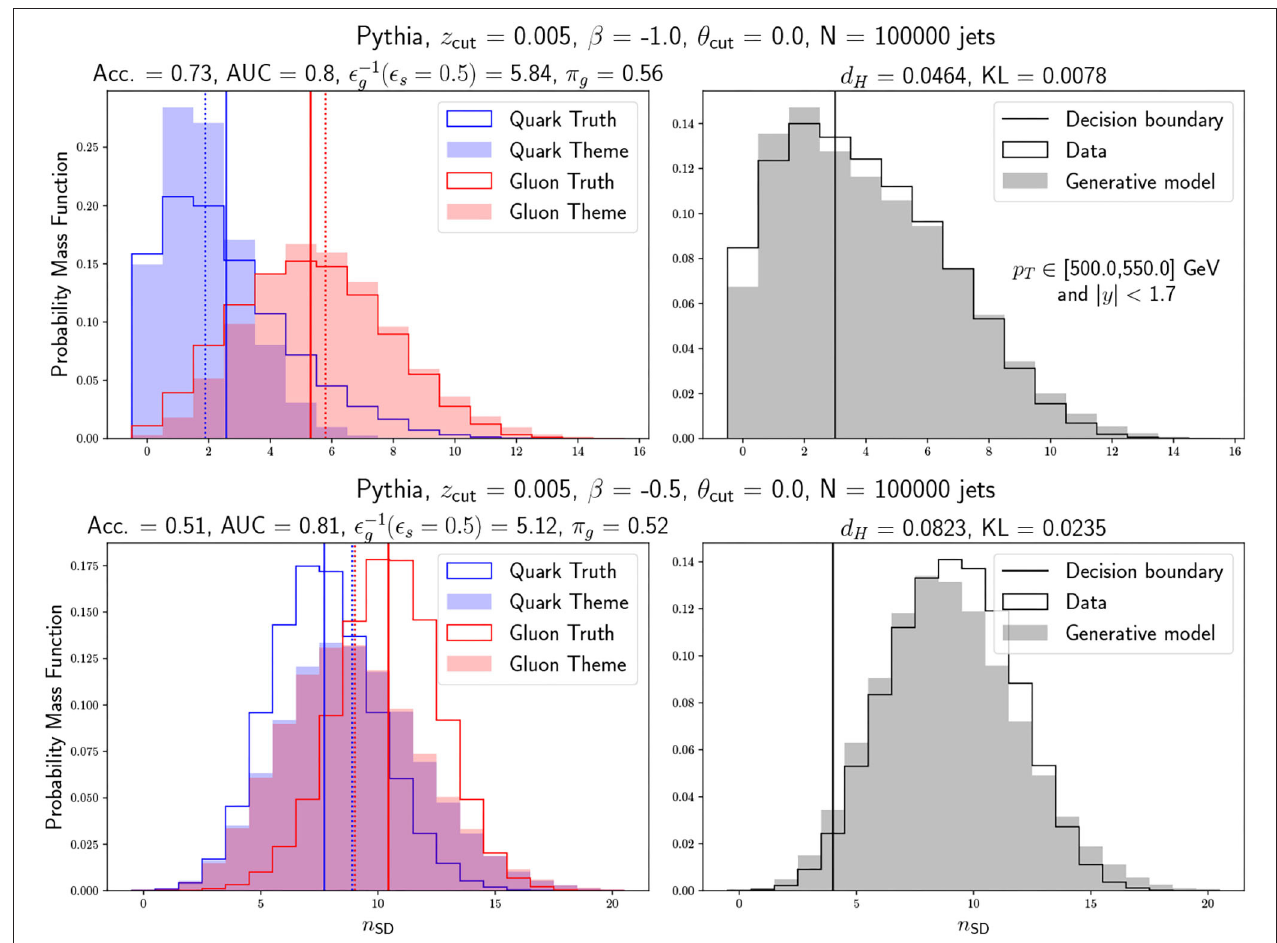
FIGURE 2 | SoftDrop multiplicity distributions for the learned quark and gluon jet themes and the correct “true” answer based on the Pythia generated sample. The upper (lower) row corresponds to a good (bad) choice of hyperparameters. This can be seen from the supervised side by the accuracy metric and from the unsupervised side by the Hellinger and KL divergence metrics which measure the consistency between the real data and pseudo-data sampled with the learned model parameters. On the left plots, we show with vertical lines the different Poisson rates while on the right plots we show with a vertical line the threshold n SD ) corresponding to p ( z quark 0.5. See text for = | =